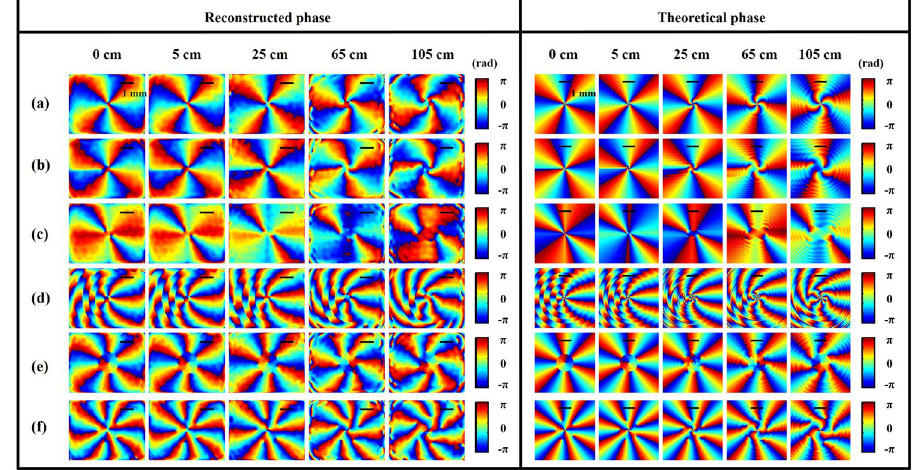
Figure 4. Spatial phase distributions of the x component of light on different cross sections. Left: reconstruction results from DH; right: simulation results. Each case corresponds to that of Fig. 2. The color bar shows the wrapped phase map between − π and π . The scale bar sketched in all figures is about 1 mm.